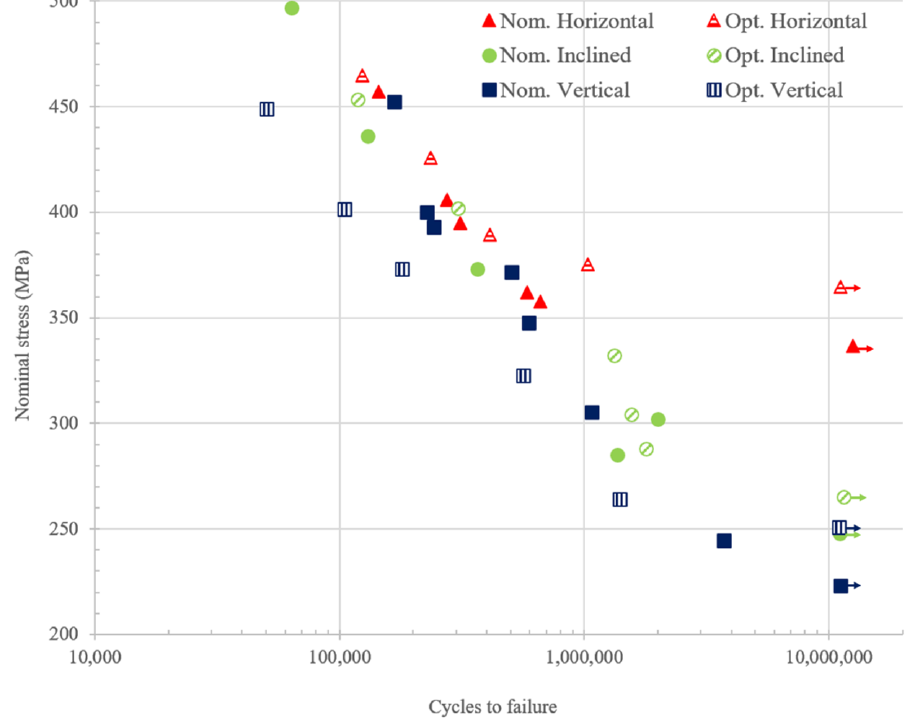
Figure 9. S-N plot of the specimens tested for horizontal, inclined, and vertical direction built with nominal and optimized